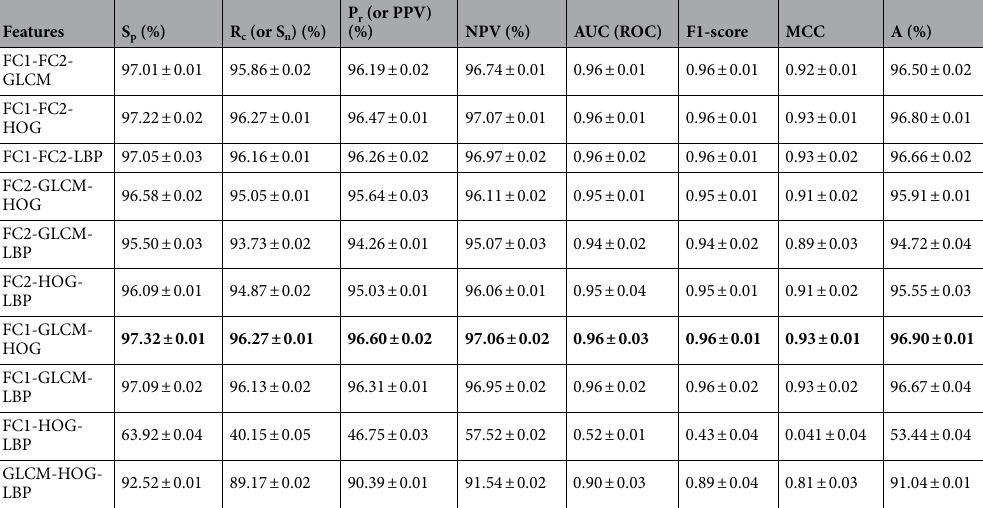
Table 16. Sensitivity analysis manifold combinations of three features using a 1-NN classifier and BraTS-2021 dataset with RA. Significant values are given in bold.